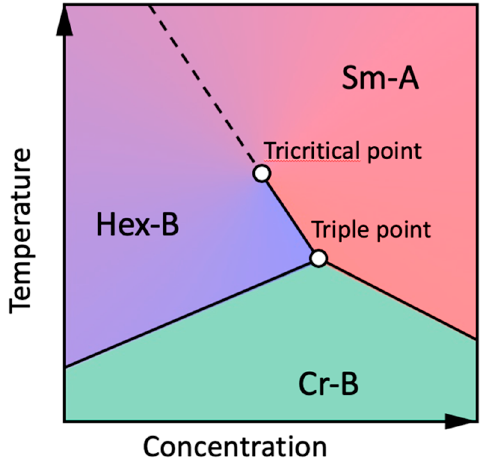
Figure 6. Generic phase diagram of the LC in the vicinity of the Hex-B–Sm-A–Cr-B triple point for a 3D case according to [40]. Solid and dashed lines correspond to the first- and second-order phase transitions, respectively (adopted from Zaluzhnyy et al. [17]—-Published by The Royal Society of Chemistry). Used under CC-BY 3.0.